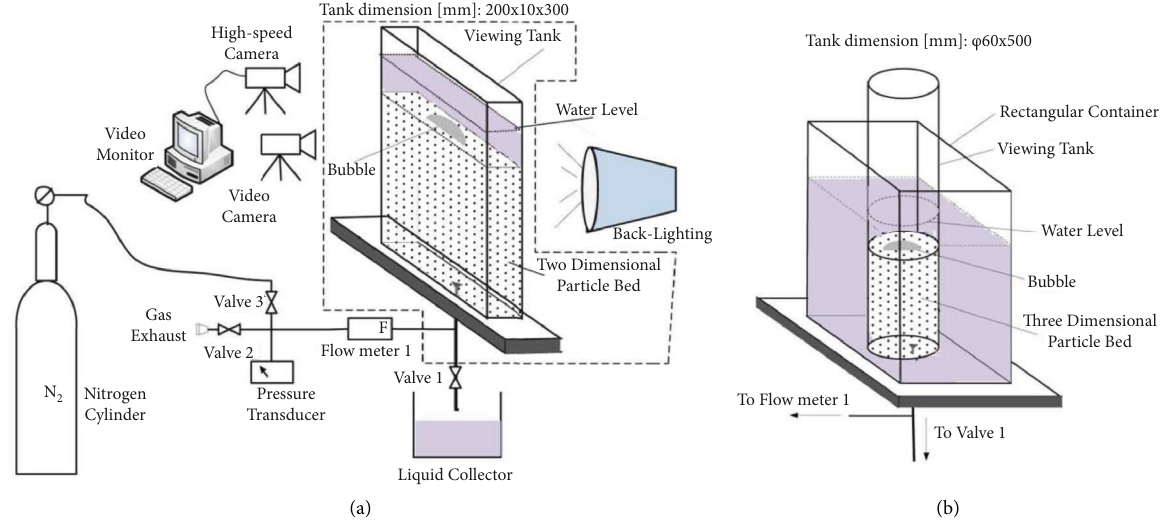
Figure 4: Experimental systems for microscopic flow regime studies with single-bubble injection [31] (a) 2D setup, (b) 3D